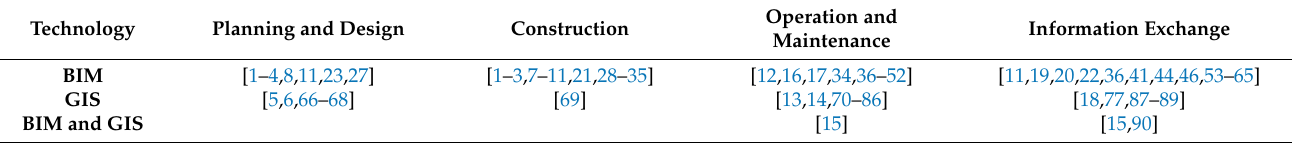
Table 2. Literature distribution of BIM/GIS applications at different stages of bridge engineering.